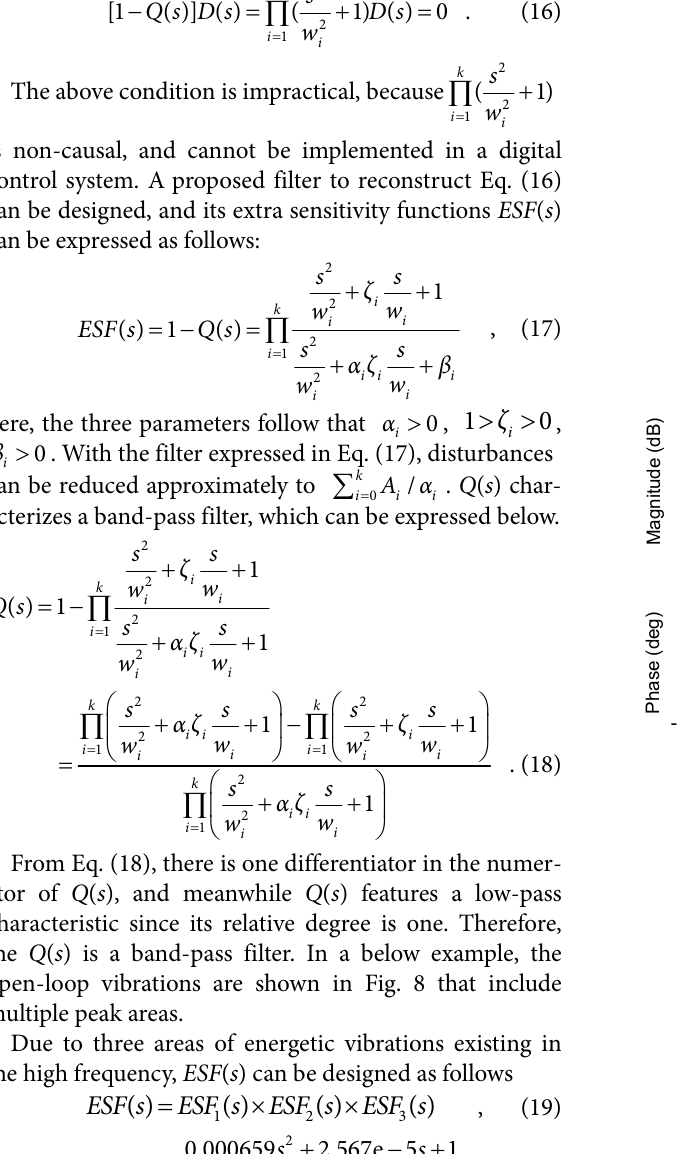
Fig. 10 | Spectra of Tip-Tilt vibrations in DOBC